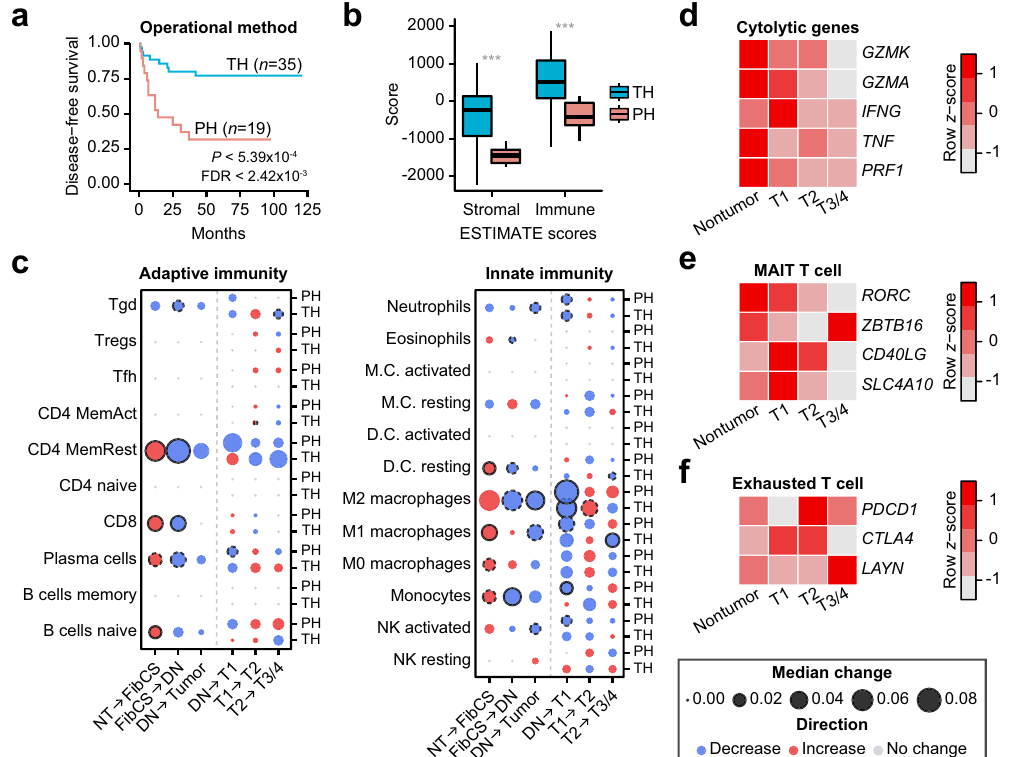
Fig. 3 Landscape of changes in 22 major immune cell types during HCC development. a Kaplan – Meier DFS estimates for patients treated with each operational method ( n = 54). b Comparison between stromal and immune scores of TH and PH. Welch ’ s t -test, *** P < 0.001. For each boxplot, the center line represents the median. The upper and lower limits of each box represent the 75th and 25th percentiles, respectively. The whiskers represent the highest and the lowest data points still within the 1.5× interquartile range. c Median fraction changes for 22 immune cell types in TH and PH in the Korean HCC cohort. Circle radii represent the magnitude of the change in median fractions between the two stages indicated below the box, and colors specify the direction of the change. Blue = decrease; red = increase; gray = no change during disease progression. Solid and dotted outlines indicate FDR and nominal P < 0.05, respectively (Welch ’ s t -test). d – f Changes in the expression of cytolytic genes ( d ), MAIT ( e ), or exhausted ( f ) T-cell markers during HCC development in TH. The scale of the changes was standardized as a z -score, which is shown in the scale ( P < 5.39 × 10 − 4 , log-rank test; Fig. 3a and Table 1), although the tumor stage and grade in the TH and PH groups were comparable to each other. Other than DFS, a few clinical parameters differed between TH and PH, probably representing patient selection or different clinical procedures prior to transplantation. For example, patients treated with embolization or ablation (pretreatment) were only found in the TH group who displayed elevated levels of fi brosis. Moreover, the tumors in the TH group showed higher immune and stromal contents and immune cell fractions than those in the PH group (Fig. 3b; stromal score, P = 1.62 × 10 − 4 ; immune score, P = 8.17 × 10 − 4 , and Supplementary Fig. 2c; P = 9.08 × 10 − 3 , Welch ’ s t -test).